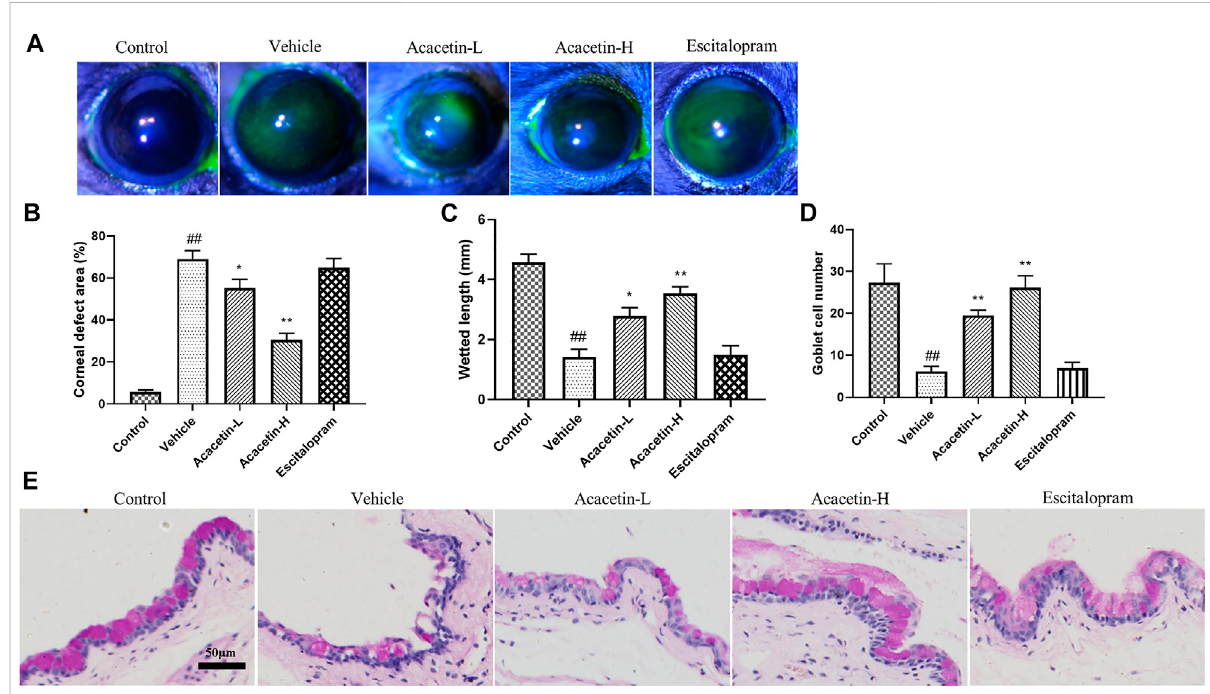
FIGURE 2 AcacetinimprovesdryeyesymptomsinCUMSmice. (A – B) Determinationofcornealepithelialdefectsby fl uoresceinstaining( n =9pergroup).